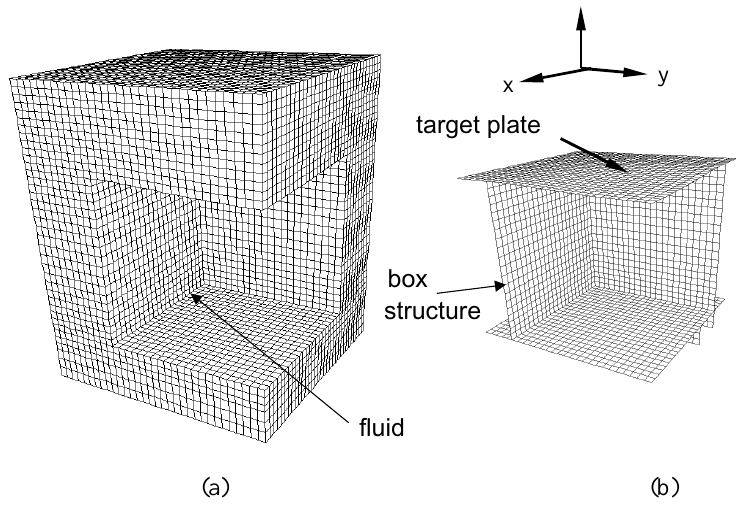
Fig. 1. The quarter symmetry models of the (a) fluid volume surrounding the box structure and (b) the box structure and target plate.